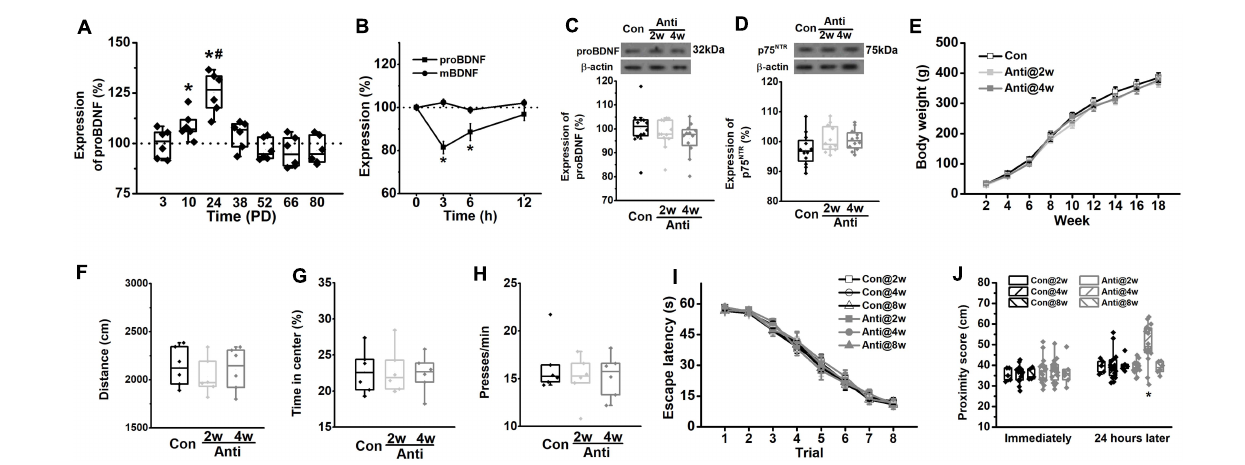
FIGURE 2 | Blockage of proBDNF expression during the postnatal period induces spatial learning impairments. (A) The level of proBDNF in the hippocampus. (* p < 0.05, vs. 100%; # p < 0.05, vs. PD10). n = 6 per time point. (B) The expression of proBDNF in the hippocampus immediately, 3, 6, and 12 h after anti-proBDNF antibody infusion. n = 6 per group. (* p < 0.05, vs. matched mBDNF). (C) The proBDNF level and (D) the p75NTR level at PD56 were detected in rats, which were infused with anti-proBDNF antibody throughout the second postnatal week (Anti2w) and the fourth postnatal week (Anti4w), respectively. n = 12 per group. (E) Bodyweight changes from PD14 to PD126. (F) Travel distance. (G) The percentage of time spent in the center of the apparatus in the open field test. n = 6 per group. (H) Press time per min in the motivation test. n = 6 per group. (I) Escape latency. (J) The swim proximity score during the MWM task. Note that